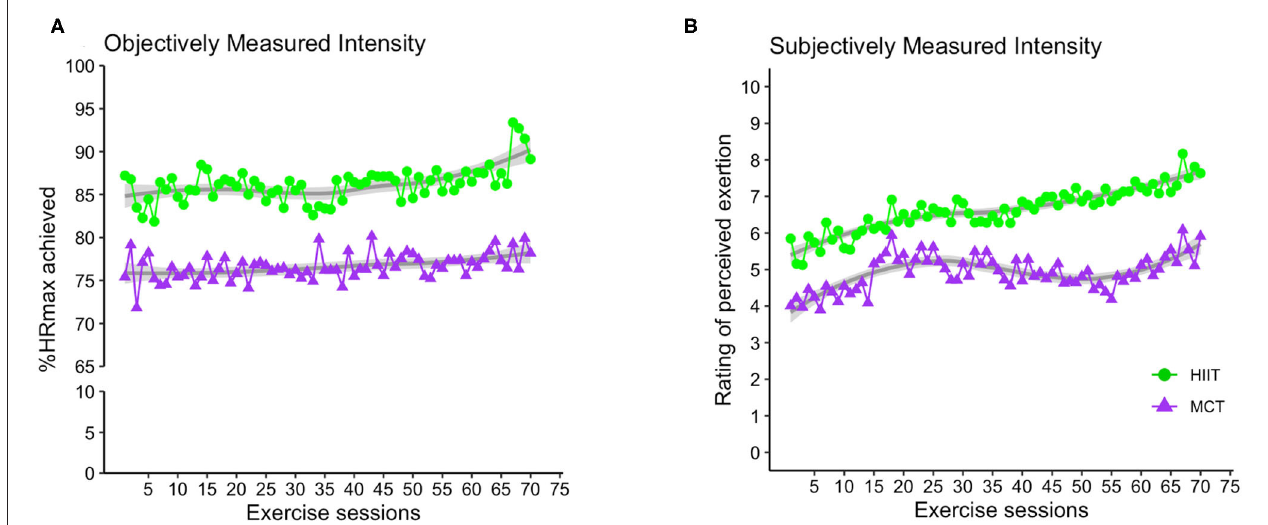
FIGURE 3 | Group average for exercise intensity achieved over the course of the exercise sessions as indexed by %HRmax (A) and RPE (B) . For the HIIT group, data shown represent average exercise intensity at the 2-min mark within each 4-min bout of HIIT exercise. For MCT group, the data indicate average exercise intensity collected at 4 different timepoints within the each MCT session (i.e., at 5, 10, 20, and 25min during the main MCT component, i.e., after 5 to 10min of warm-up). %HRmax, percentage of maximum heart rate; RPE, rating of perceived exertion; HIIT, high-intensity interval training; MCT, moderate-intensity continuous